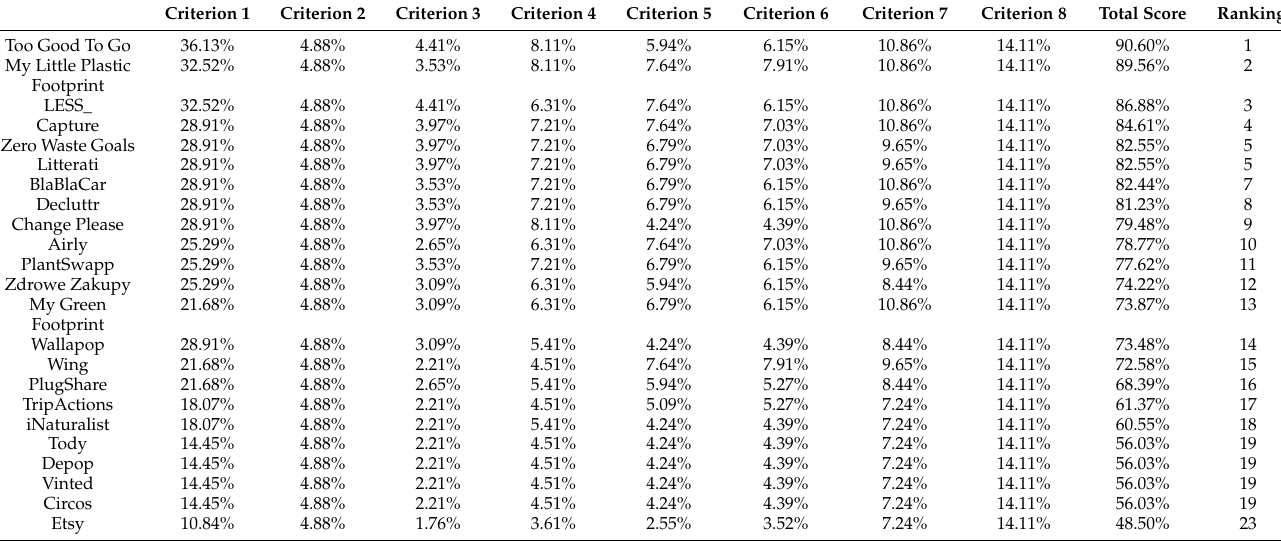
Table 7. The final matrix containing the results from the assessment of companies in terms of social values together with the ranking (own